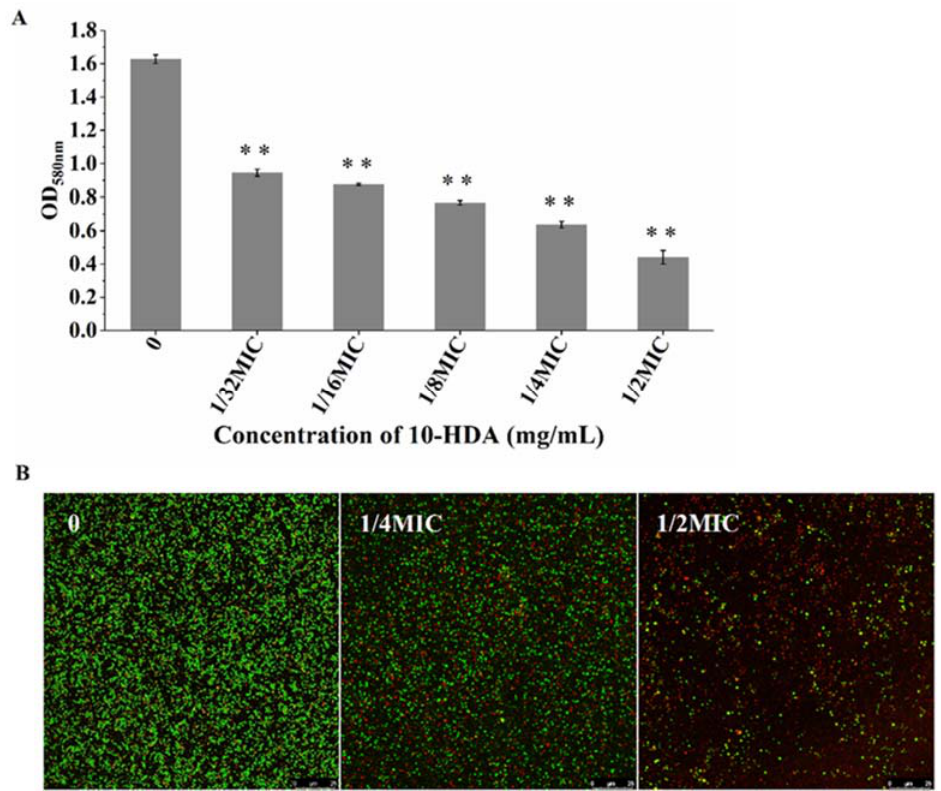
Figure 3. Effect of 10-HDA on bacterial viability during biofilm formation. ( A ) Effect of 10-HDA on the metabolic activity of the cells in S. aureus biofilms, as analyzed by MTT assay. ** p < 0.01. ( B ) CLSM images of S. aureus biofilms. Green fluorescence: live cells; red fluorescence: dead cells.